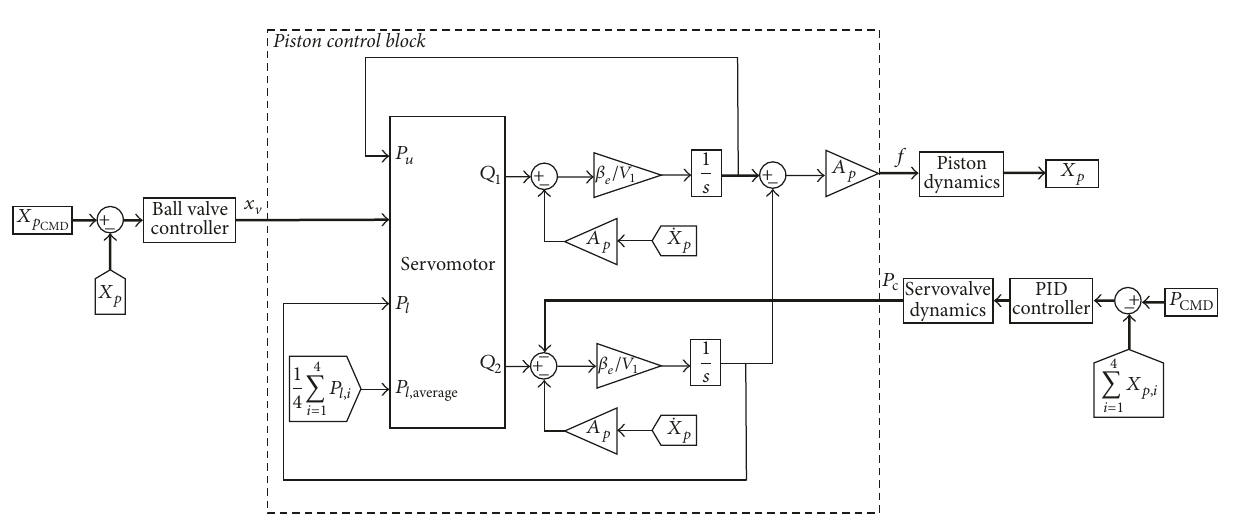
Figure 12: Simulated configuration for 1